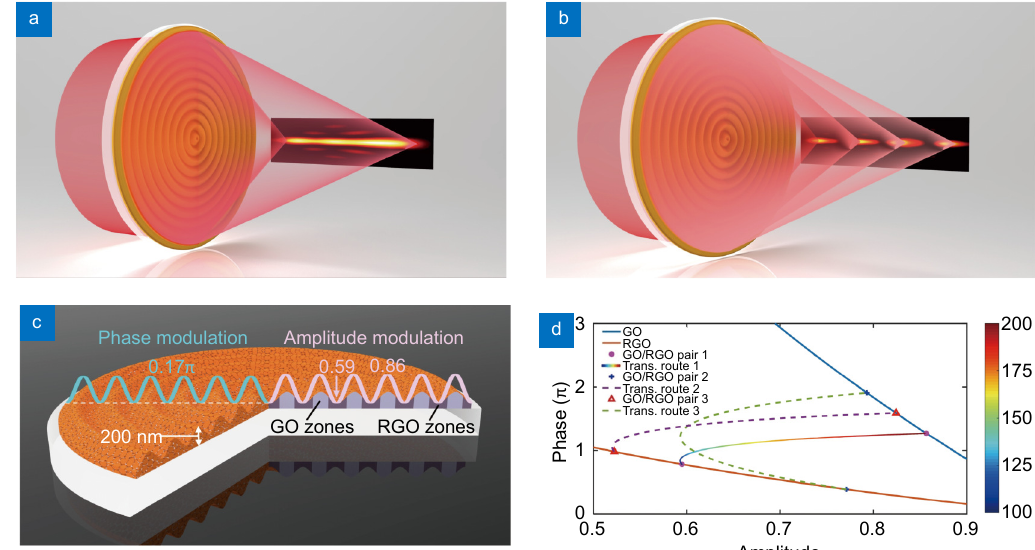
Fig. 1 | Schematic figures of GO metalens and its demonstrations. ( a ) Optical demonstration for optical needle generated by GO metalens. ( b ) Optical demonstration for four axial focal spots generated by GO metalens. ( c ) Schematic figure of GO metalens on a glass substrate, the total thickness is 200 nm. When reduced by femtosecond laser in RGO area, the absorption and refractive index increase while the thickness is reduced to 100 nm. ( d ) Phase-amplitude relationship of GO/RGO pairs. Three GO/RGO pairs on blue and brown lines, whose thicknesses are 200 nm/100 nm, 300 nm/150 nm, and 250 nm/125 nm, are labelled with dot (●), cross (+), and triangle (Δ), respectively. The first and the second numbers indicate the thickness of the initial GO films (e.g. 200 nm) and the thickness (e.g. 100 nm) of RGO after laser reduction. The transitional routes between GO/RGO pairs are plotted. The GO/RGO pairs with dot marker and transitional route 1 with solid lines are utilized in this work. The colorbar relates to thickness of the RGO film, which is controlled by the laser reduction